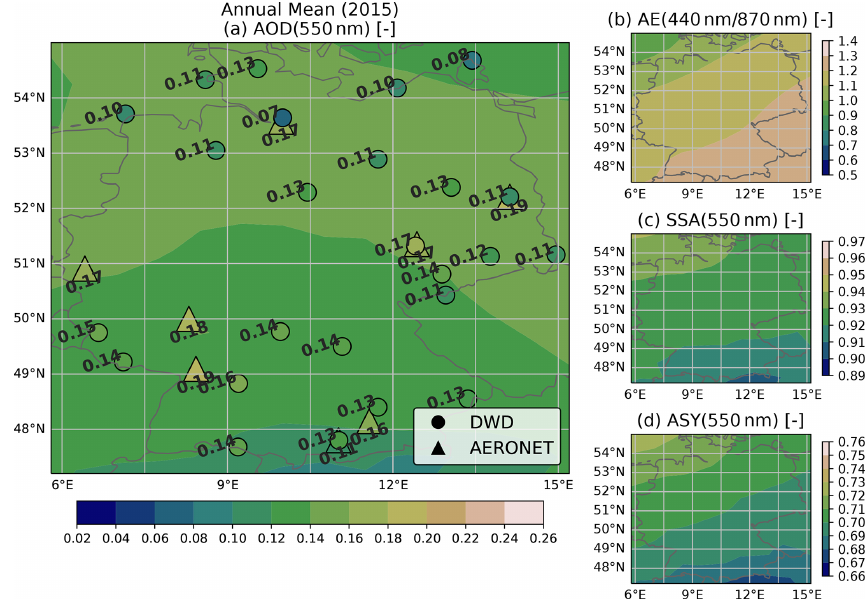
Figure 11. Annual mean of aerosol properties at the surface over Germany. The calculation is conducted with the T–CARS setup. In addition for the AOD (a) , annual-mean values as observed from measurement stations from AERONET (triangles) and DWD (circles) are shown. Note that considerable differences between T–CARS and measurement stations may be attributed due to sampling effects on the estimation of the annual mean, localized intense sources of aerosol (inner cities) and terrain inhomogeneity (e.g. Gueymard and Yang, 2020).